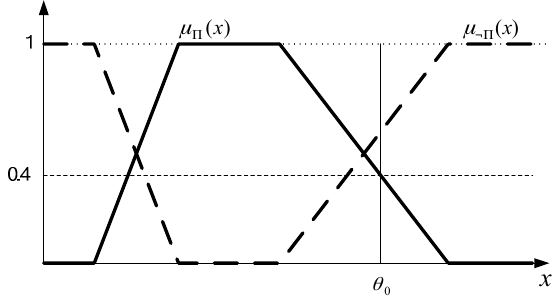
Figure 1. Testing function ϕ of Grzegorzewski